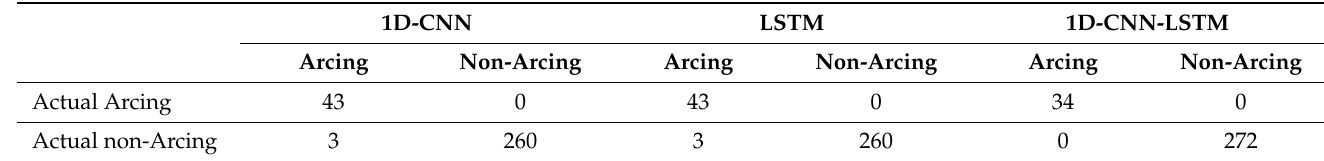
Table 5. Training Phase Output Matrix: Time Domain Arcing Fault Classification.